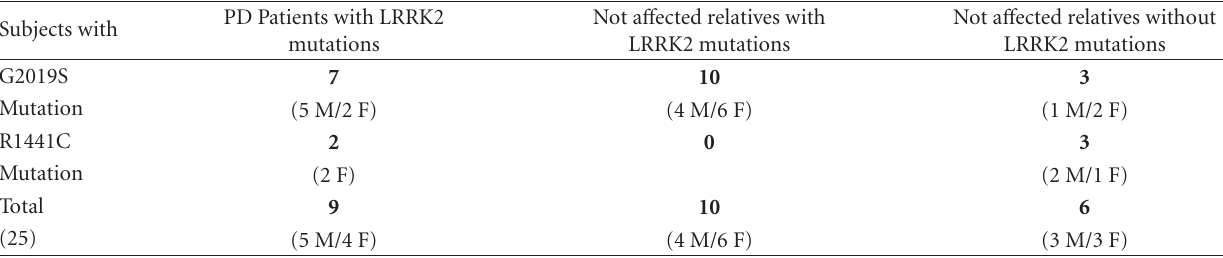
Table 2: Study of families with LRRK2 mutations.